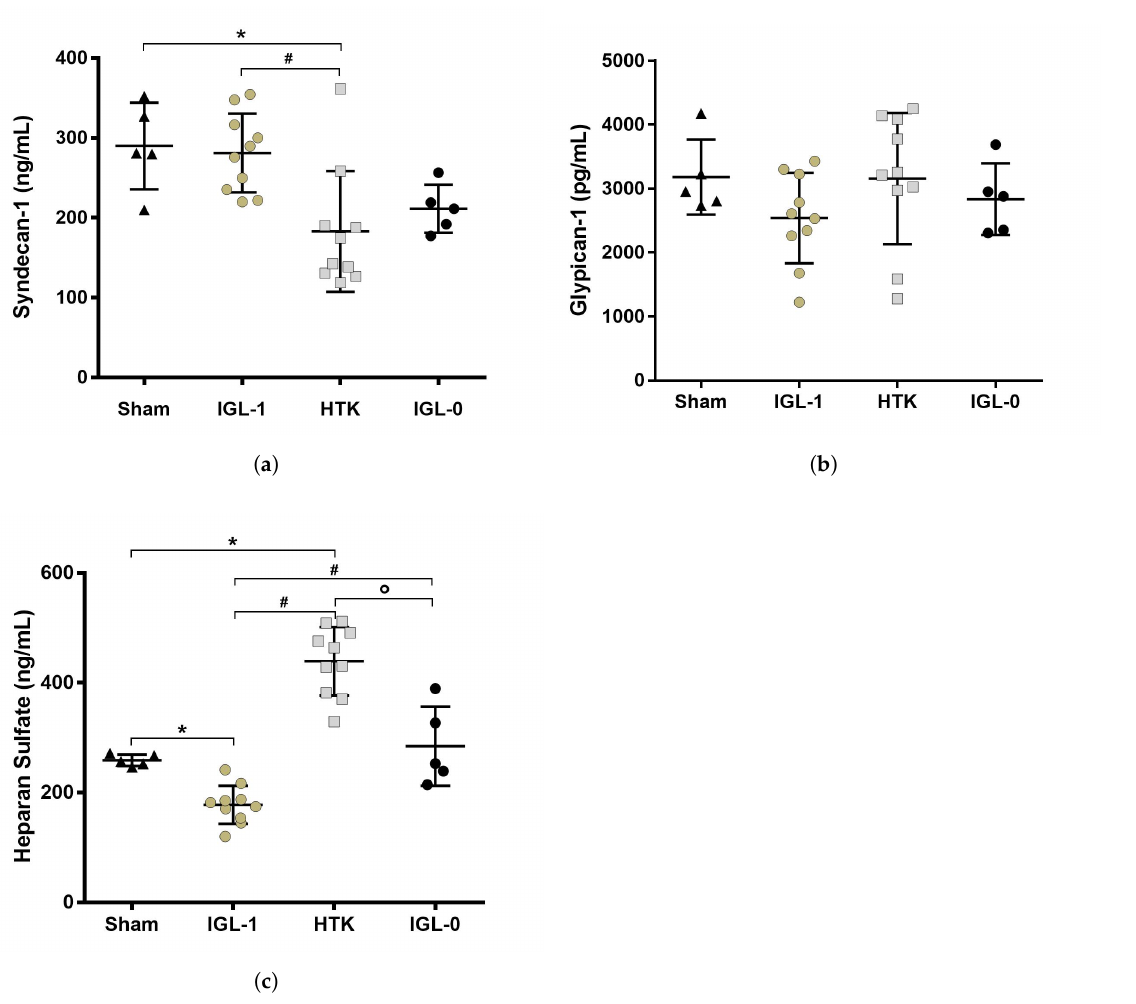
Figure 3. Glycocalyx protection in fatty livers after 24 h of cold storage. Protein expression of the three main components of the glycocalyx were measured by ELISA from tissue samples. ( a ) Syndecan-1 level was lower in HTK group compared to Sham and IGL-1 groups; ( b ) glypican-1 expression was the same in all the groups; ( c ) Heparan sulfate expression was lower in IGL-1 group compared to the three other groups and the opposite for HTK which expressed a higher level of HS. Results are presented as mean (SD), IGL-1/HTK n = 10/group, Sham/IGL-0 n = 5/group, * p < 0.05 vs. Sham; # p < 0.05 vs. IGL-1; ° p < 0.05 vs. HTK (One-way